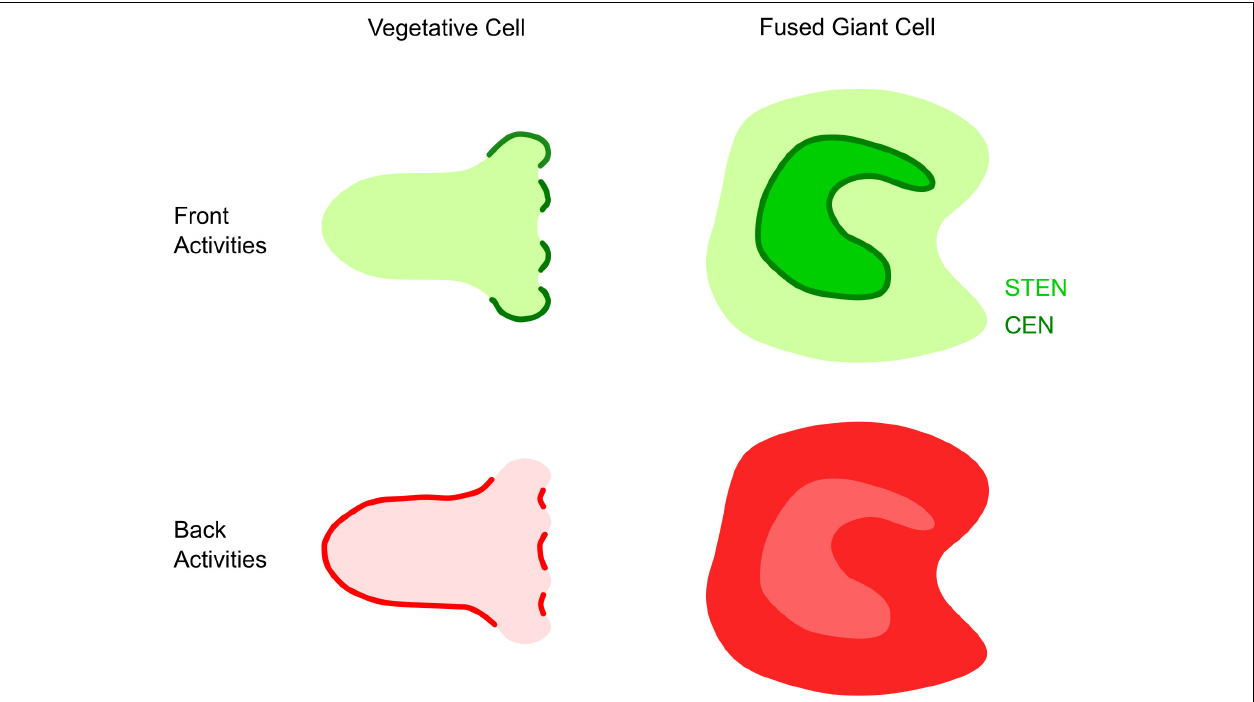
FIGURE 3 | Front and back organization in Dictyostelium . Illustration of “front” and “back” activities in the middle focal plane of a single vegetative cells and the bottom membrane of giant cells. Left: in single cells, front (green) activities occur at protrusions or macropinocytic cups, while back (red) activities display complementary patterns at the trailing edge of macropinocytic cups or the cell. Right: in giant cells, front activities (green) propagate as cortical waves. STEN (light green) activities are enclosed by CEN (dark green). Back activities (dark red) are excluded from the area of front activity, creating “shadow waves” of low intensity when imaging back biosensors (light